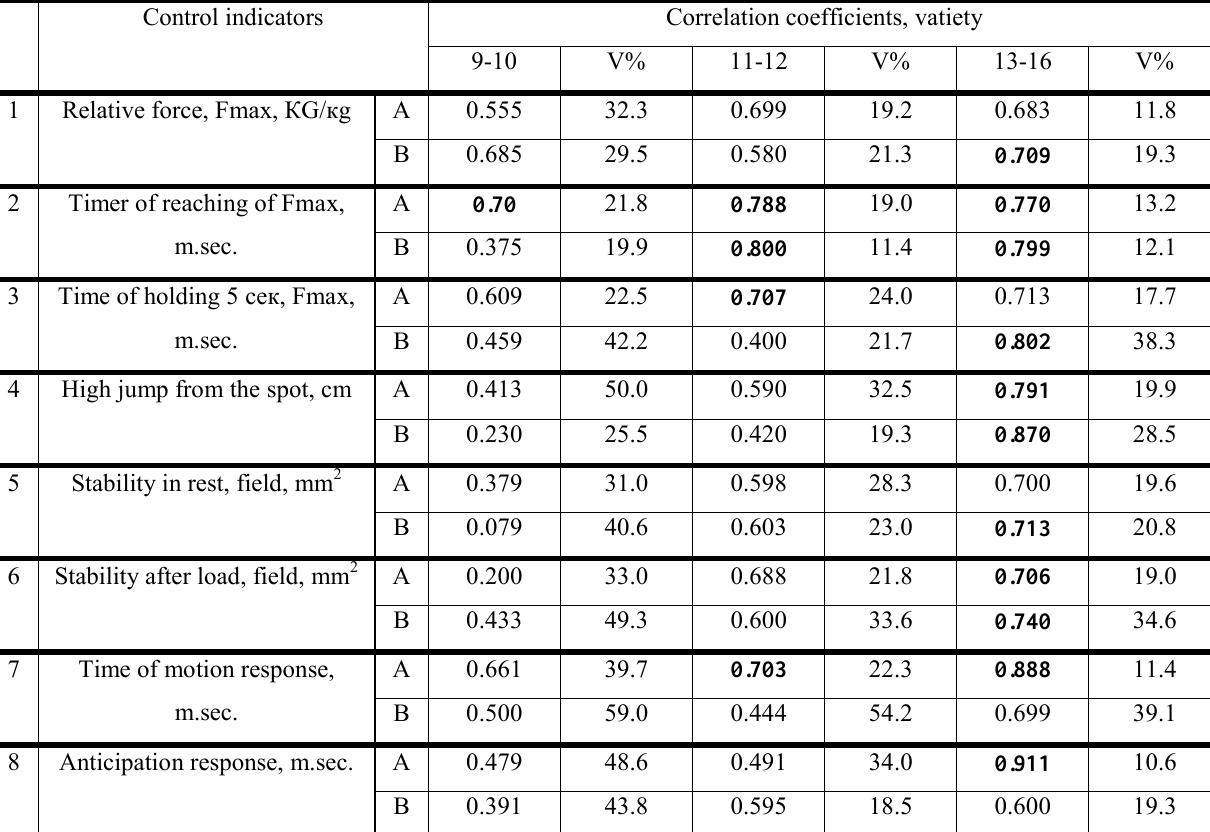
Reliability of control tests’ measurements by indicator of compatibility of repeated attempts’ results (r tt ) of different age female gymnasts (А) and gymnasts (B